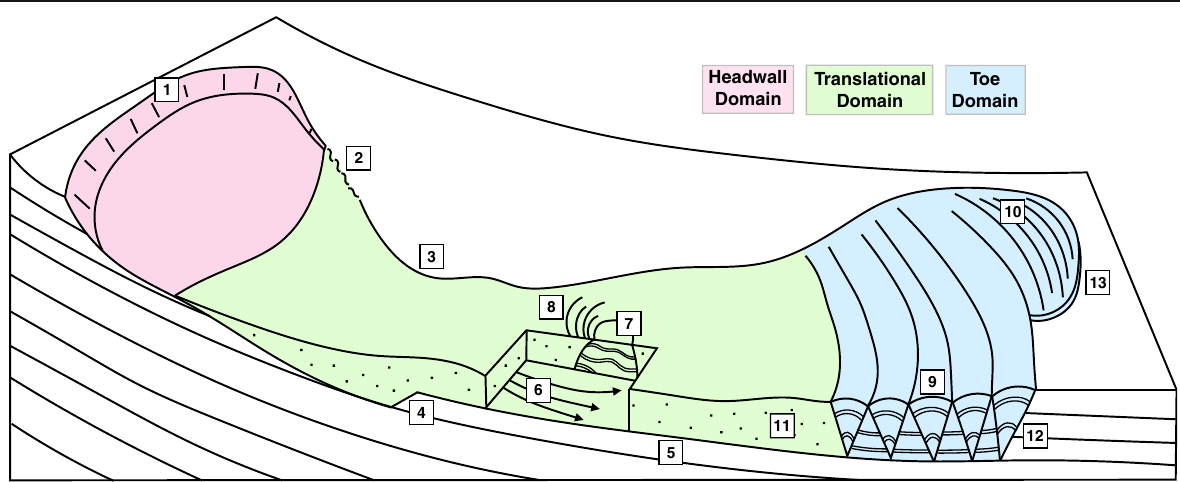
Fig. 2 Key geometric and geologic criteria for kinematic indicator recognition. 1 — headwall scarp. The direction of initial movement roughly perpendicular to the headwall propagation. 2 — en-echelon sigmoidal segments. Strike-slip affected MTD material differentiates lateral margin from headwall scarp. 3 — lateral margins. Delimits strike-parallel extent of MTD and constrains gross general transport direction. 4 — ramp. Location(s) where the BSS jumps to a higher stratigraphic level. 5 — flat. Location(s) where the BSS is parallel with local stratigraphy. 6 — grooves. Implies debris flow processes with a translation parallel to their trend. 7 — translated block. Often align long-axis downslope. 8 — secondary flow fabric. Translation direction indicated by the trend of flow parallel banding. 9 — pop-up blocks. Typically hundreds of meters high, translation perpendicular to the alignment of ridges. 10 — pressure ridges. Typically tens of meters high, translation perpendicular to the strike of thrust faults. 11 — MTD matrix. 12 — frontally confined toe. 13 — frontally emergent toe. BSS — basal shear surface. MTD — mass transport deposit. Modified after Bull et al. (2009)